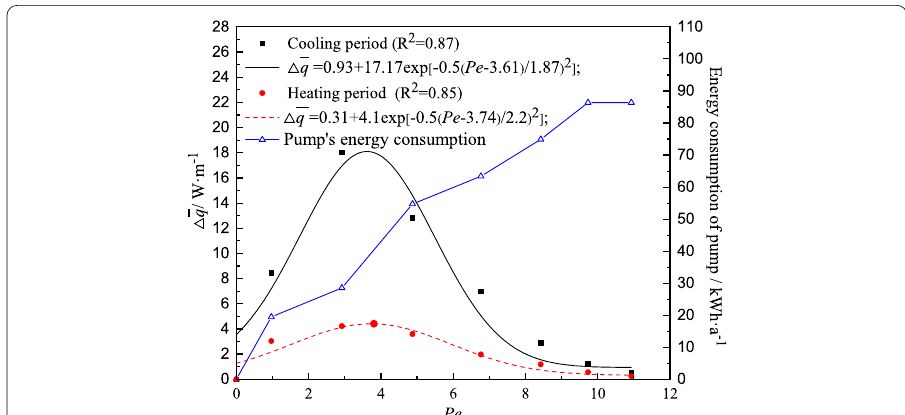
Fig. 15 The total energy consumption of pumps and the increment of heat transfer rate per unit depth of ¯ q ¯ q the BHEs (Δ ¯ q t + 1 − t ) change over =